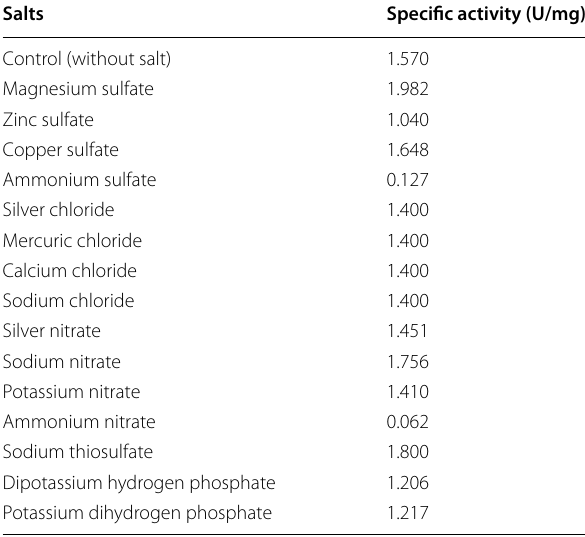
Table 2 Effect of salts on activity of purified enzyme Salts